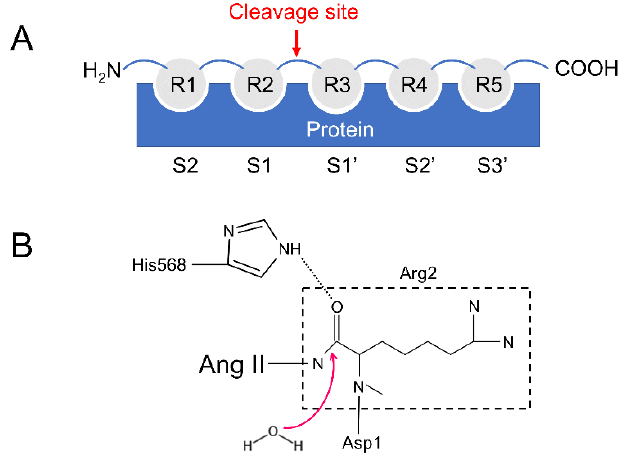
Figure 2. ( A ) The number of each subsite of hDPP III. ( B ) Possible catalytic mechanism of hDPP III.